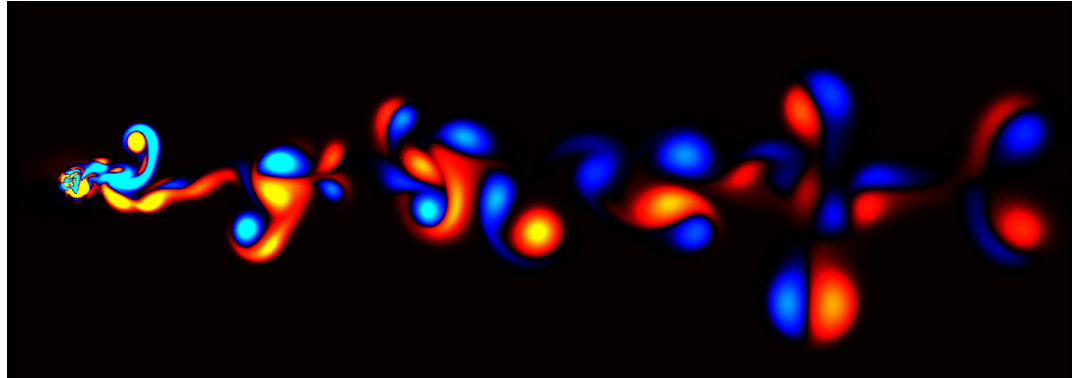
Figure 4 . Fixed-time snapshot of a turbulent wake of a gravitationally induced deformation of a large- D black brane horizon in AdS. In this picture the fluid flows from left to right, past a circularly-symmetric Gaussian deformation at the left hand side, which was quenched from zero amplitude. This deformation corresponds to quenching a gravitational potential at the boundary of AdS. At late times the system will equilibrate as the fluid relaxes to the rest frame of the deformation. Colour indicates the